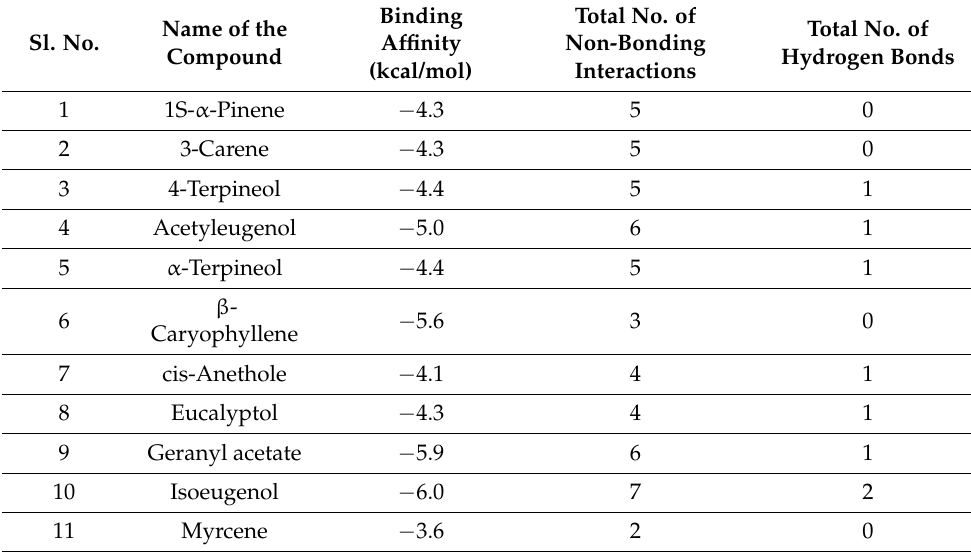
Table 5. Binding affinity and non-bonding interactions of compounds with the target proteins.